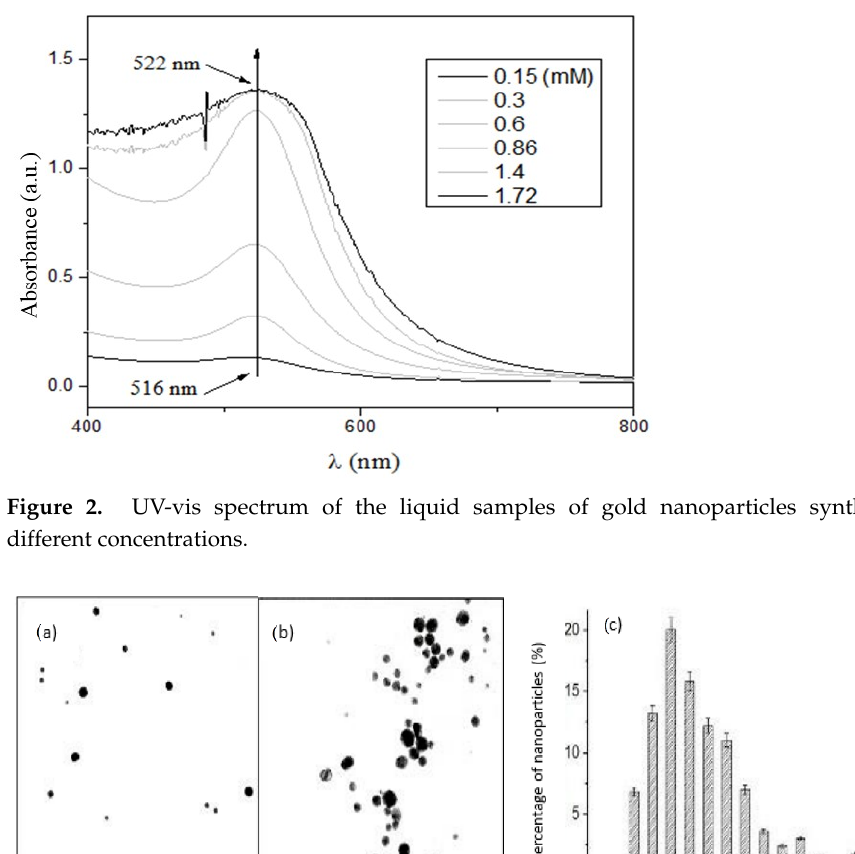
Figure 3. Transmission electron microscopy of CTS-AuNPs obtained from solution with ( a ) 0.3 and ( b ) 1.07 mM of HAuCl 4 ; ( c ) the particle size distribution histogram of CTS-Au-NPs obtained from TEM micrographics.